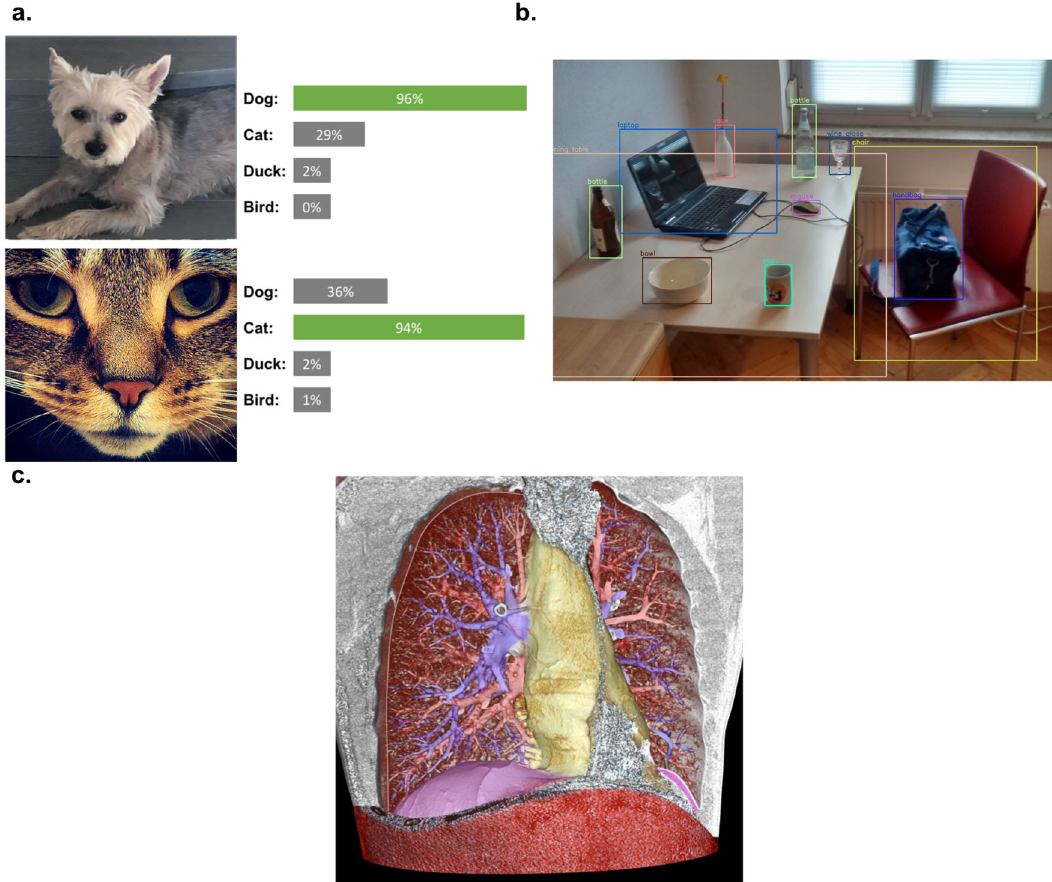
Fig. 2 Image tasks in computer vision. Examples of ( a ) image classi fi cation, in which the task is one of classifying an image as one of 4 different types of animals ( b ) object detection, in which not only are objects classi fi ed but also identi fi ed in the image with boxes around their respective location and ( c ) image segmentation, where every pixel in the image is translated into some label, here the vessels, airways and contours of a lung. Sources: ( a ) the author ’ s photographs of dog (DM) and Jonesy the cat (AA). b https://commons.wikimedia.org/wiki/ File:Detected-with-YOLO--Schreibtisch-mit-Objekten.jpg ( c )